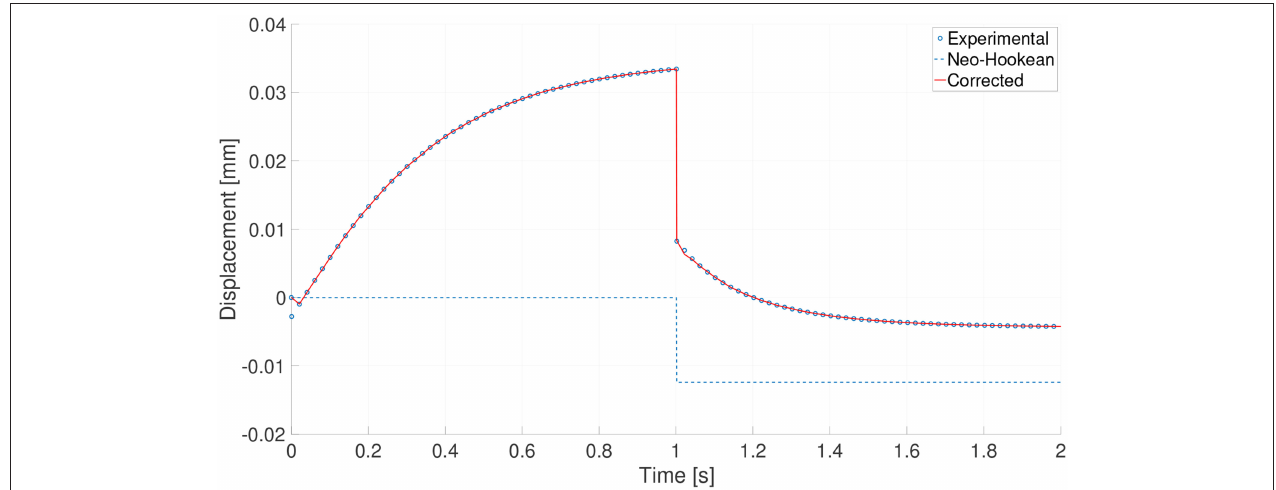
FIGURE 8 | Experimental results (circles), prediction made by the neo-Hookean model (dashed line) and corrected model (red line) for experiment number 85.